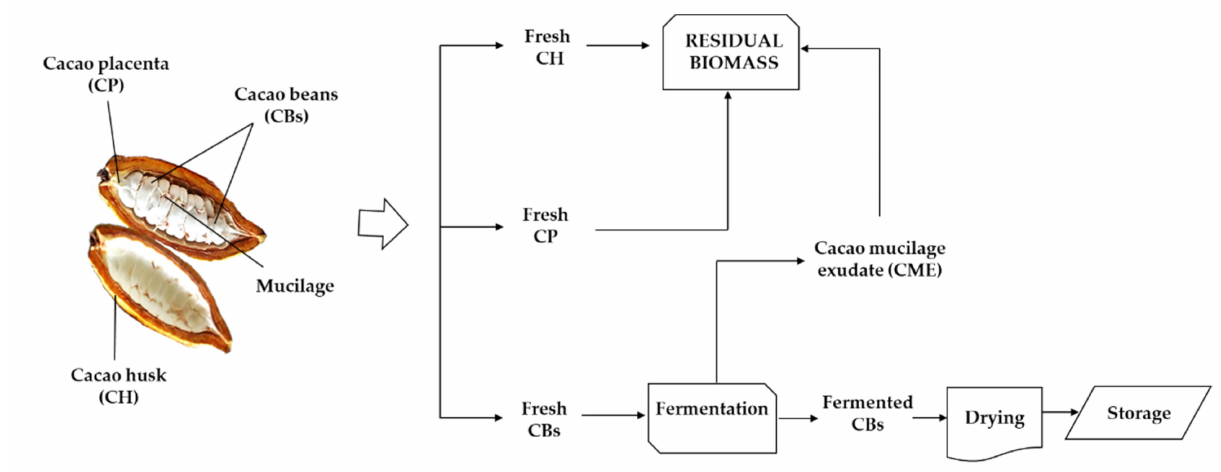
Figure 1. Traditional scheme for cacao fruit processing in tropical cacao-producing